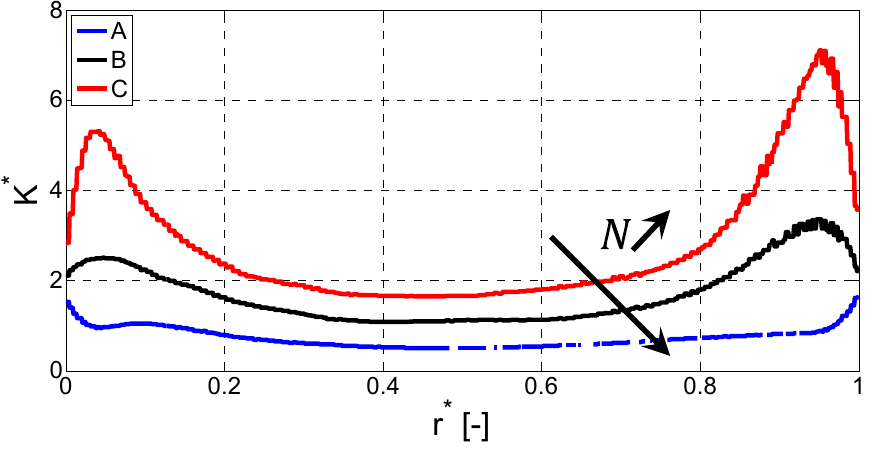
Figure 11. Radial distribution of the energy redistribution parameter obtained by the LES OneEqEddy